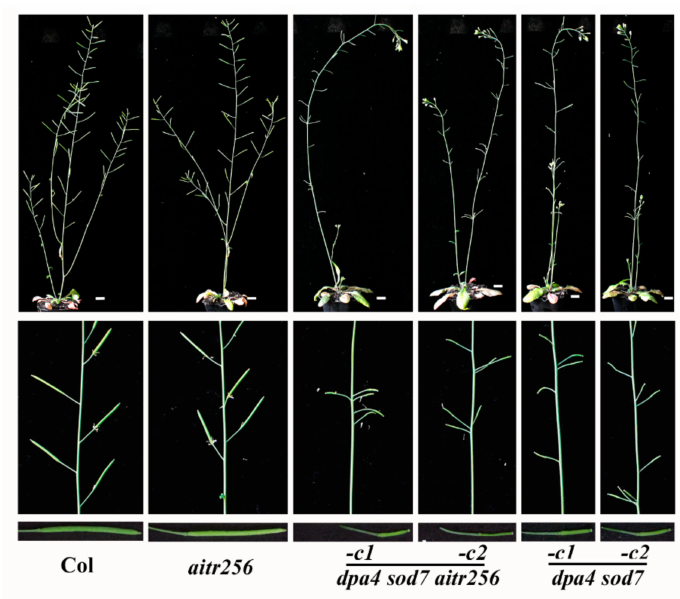
Figure 5. Inflorescence architecture in the dpa4 sod7 aitr256 quintuple and the dpa4 sod7 double mutants. Seeds of the Col wild type, the aitr256 triple, the dpa4 sod7 aitr256 quintuple and the dpa4 sod7 double mutants were generated and grown in soil pots for 30 days with su ffi cient watering. Pictures for inflorescences were taken from 7-week-old plants, for siliques were taken from 6-week-old plants. Upper panel, inflorescences of 7-week-old plants, middle panel, siliques arrangement on the main inflorescence stems, lower panel, 8th siliques on main inflorescence